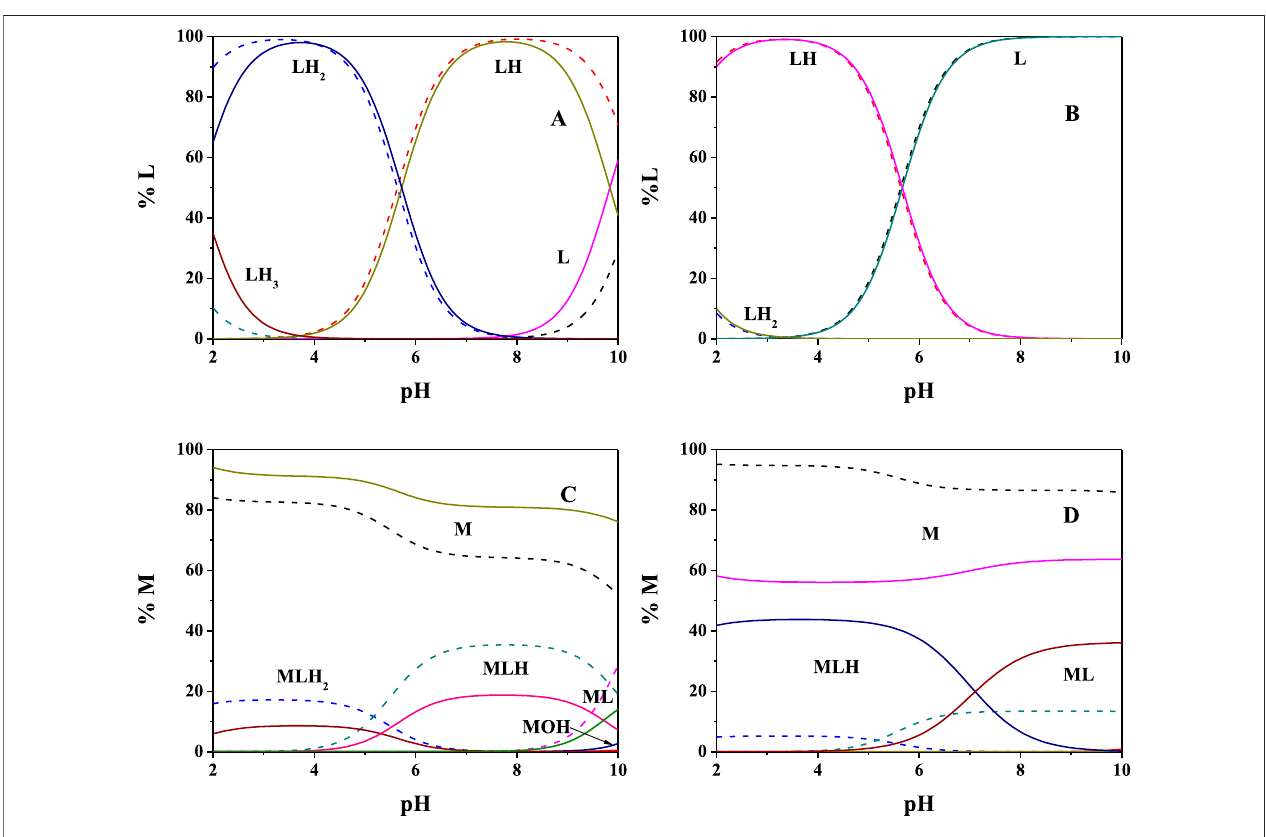
FIGURE2| Speciationdiagramsat t =15 ° C(dotted lines)and t =37 ° C(solidlines)for (A) L= PEA,(B) L= PPC (C L =5 mmol L − 1 and I =0.15 mol L − 1 inNaCl); (C) Mg 2+ (M)- PEA (L), and (D) Mg 2+ (M)- PPC (L) (C M = 2 mmol L − 1 , C L = 4 mmol L − 1 , and I = 0.15 mol L − 1 in NaCl).